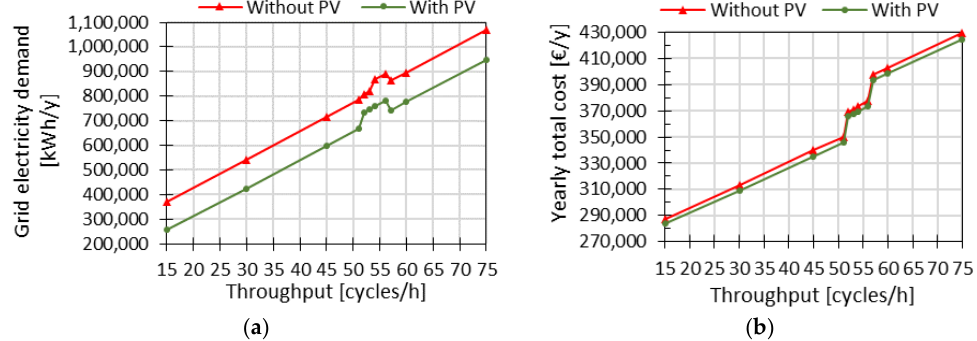
Figure 12. Sensitivity analysis on system throughput: ( a ) electricity withdrawal from the grid and ( b ) yearly total cost. Table 5. R-AS/RS with PV plant: optimal rack configurations with minimum yearly total cost for different system throughputs.